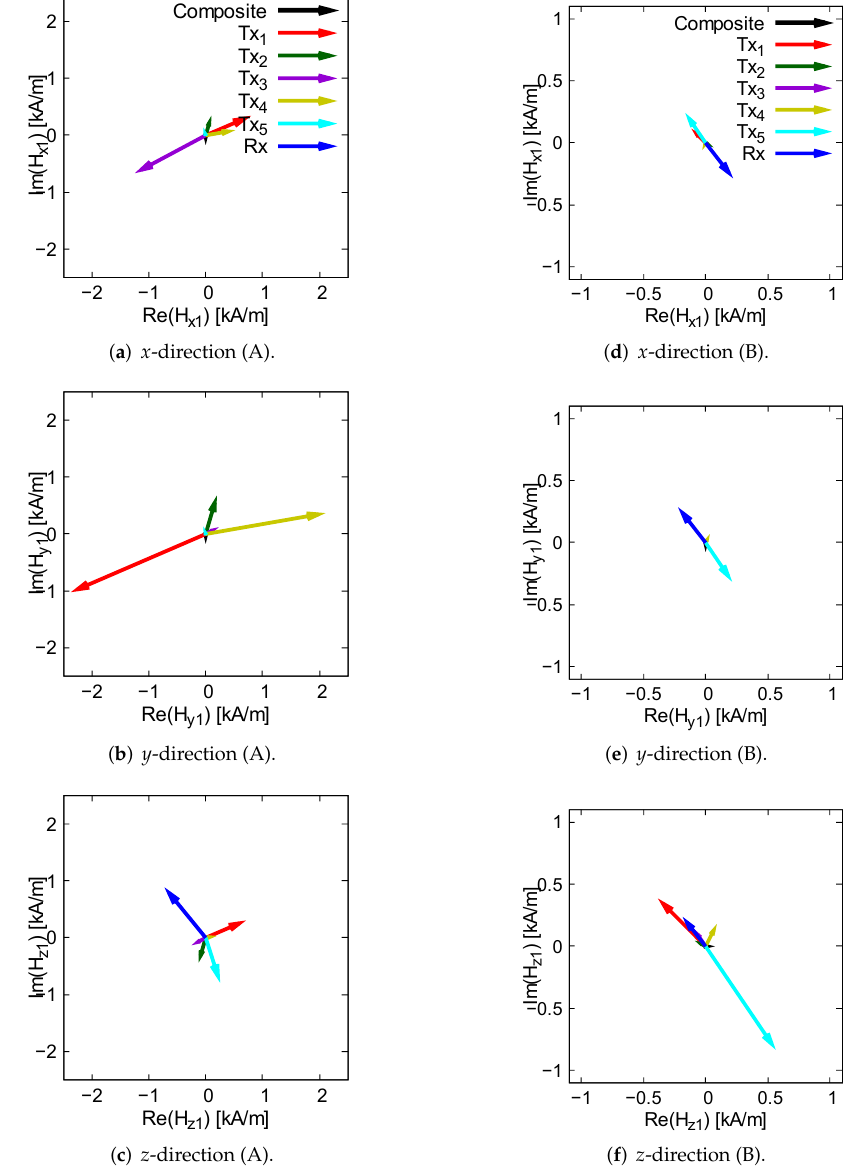
Figure 14. Phasor representation of the magnetic field in each direction ( α = 0.9, five Tx coils, k = 1): ( a – c ) magnetic field at A; ( d – f ) magnetic field at B. The power input to each Tx coil at B was Tx 1 = 79 W, Tx 2 = − 216 W, Tx 3 = 11, 191 W, Tx 4 = 24, 243 W and Tx 5 = − 22, 575 W. This indicates that Tx 3 and Tx 4 mainly contributed to the power transmission. However, since these coils were located a distance away from B, they had little effect on the magnetic field in each direction, as shown in Figure 14d–f. Therefore, Tx 3 and Tx 4 were mainly used for power transmission; the other three Tx coils, including Rx, were mainly used for magnetic field suppression. Compared with three Tx coils, the number of coils that could be used mainly for magnetic field suppression increased, thus leading to a more effective suppression. Here, the vectors generated by Rx in Figure 14a,b and the Tx 1 and Tx 2 in Figure 14e were zero vectors and the other vectors were non-zero, although several were difficult to recognize due to their small